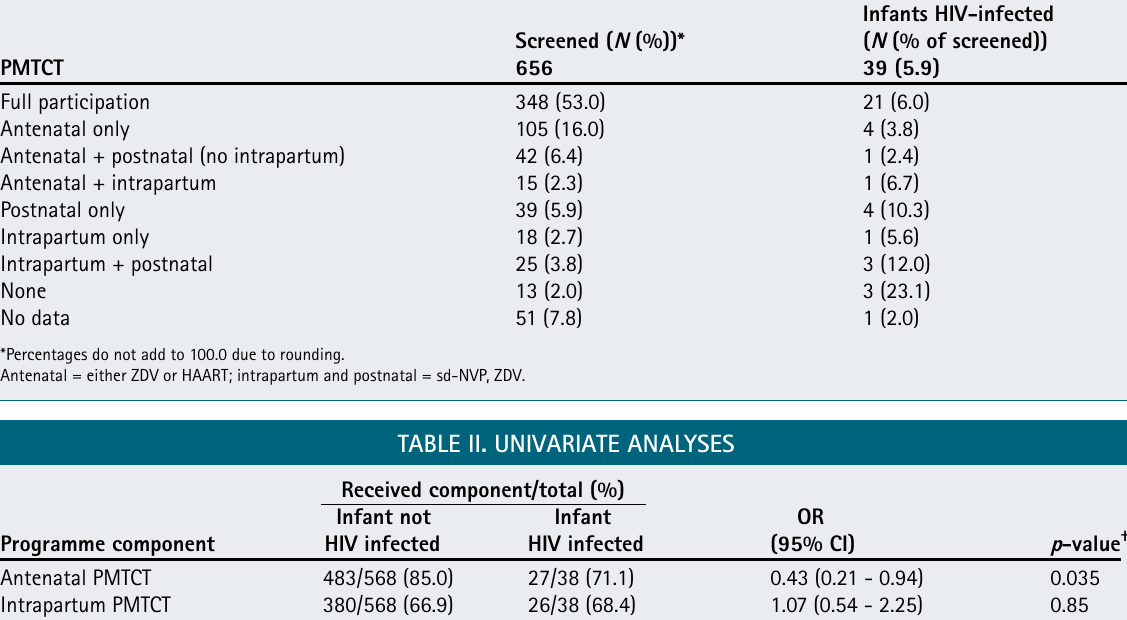
TABLE I. EXTENT OF PARTICIPATION OF MOTHERS AND THEIR INFANTS IN THE PMTCT PROGRAMME AND HIV TRANSMISSION